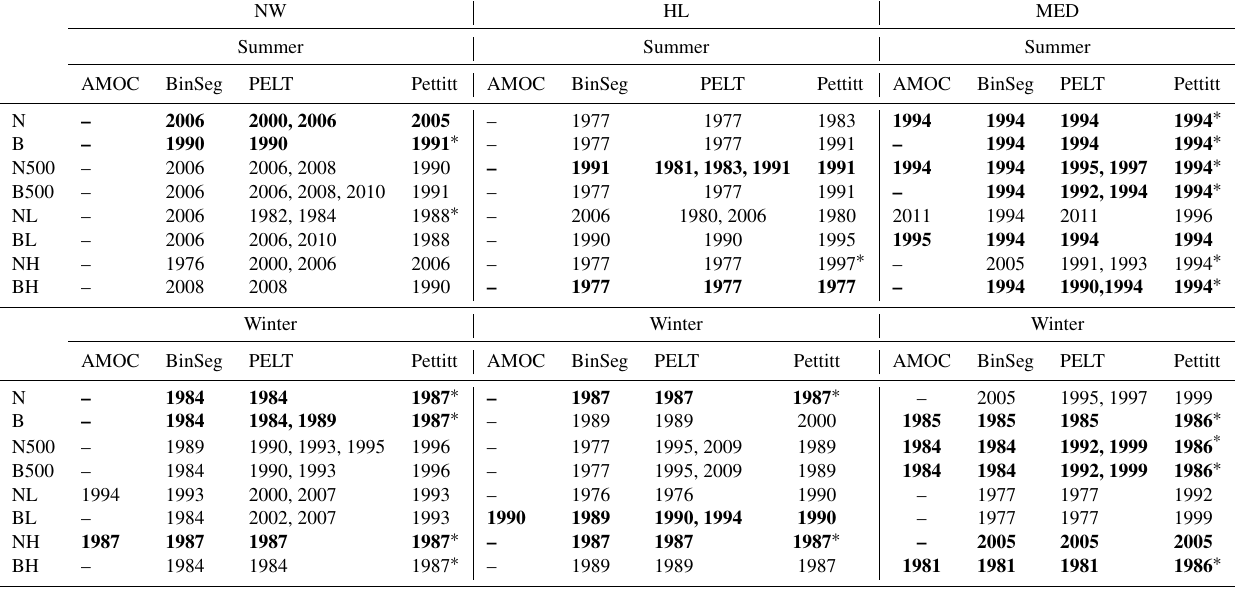
Table 2. Change points for AMOC (at most one change), BinSeg (binary segmentation), PELT (pruned exact linear time) methods and Pettitt test ( ∗ significant changes p value < 0 . 05) by fire feature, region and season from the period 1974–2013. Bold features indicate matching probable changes in at least three methods. NW is Northwest, HL is Hinterland and MED is the Mediterranean. See Sect. 2.1 for acronyms and description of fire